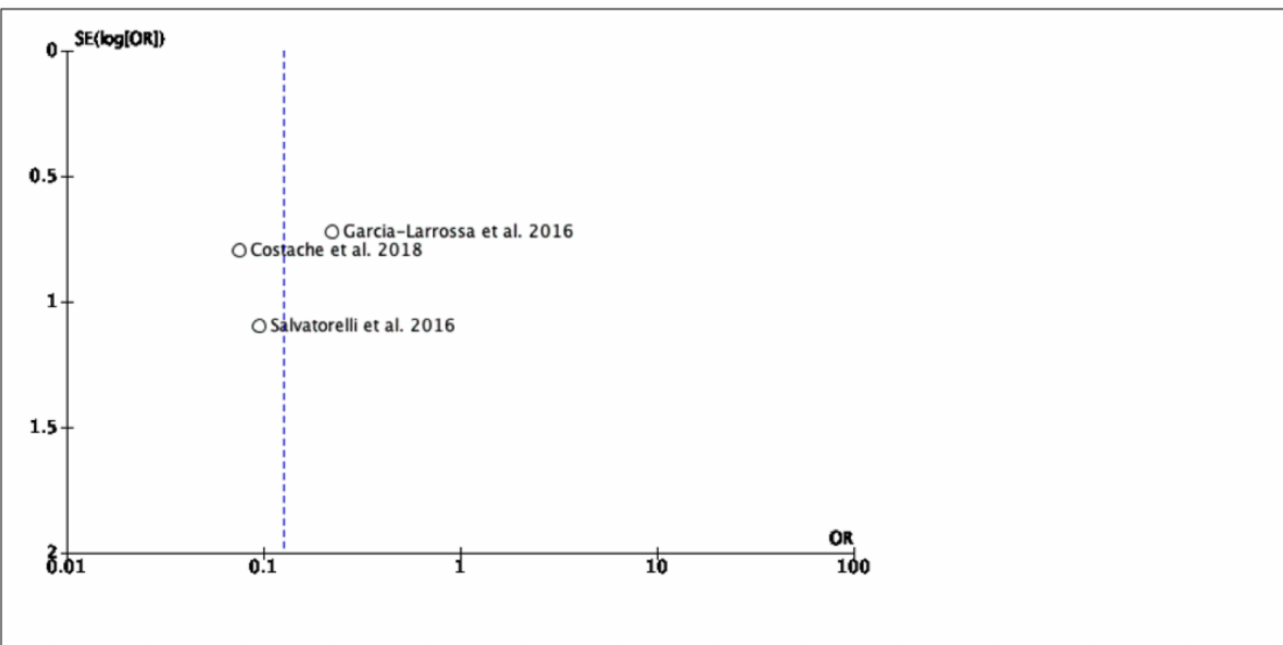
Figure 3. The figure shows the funnel plot for publication bias